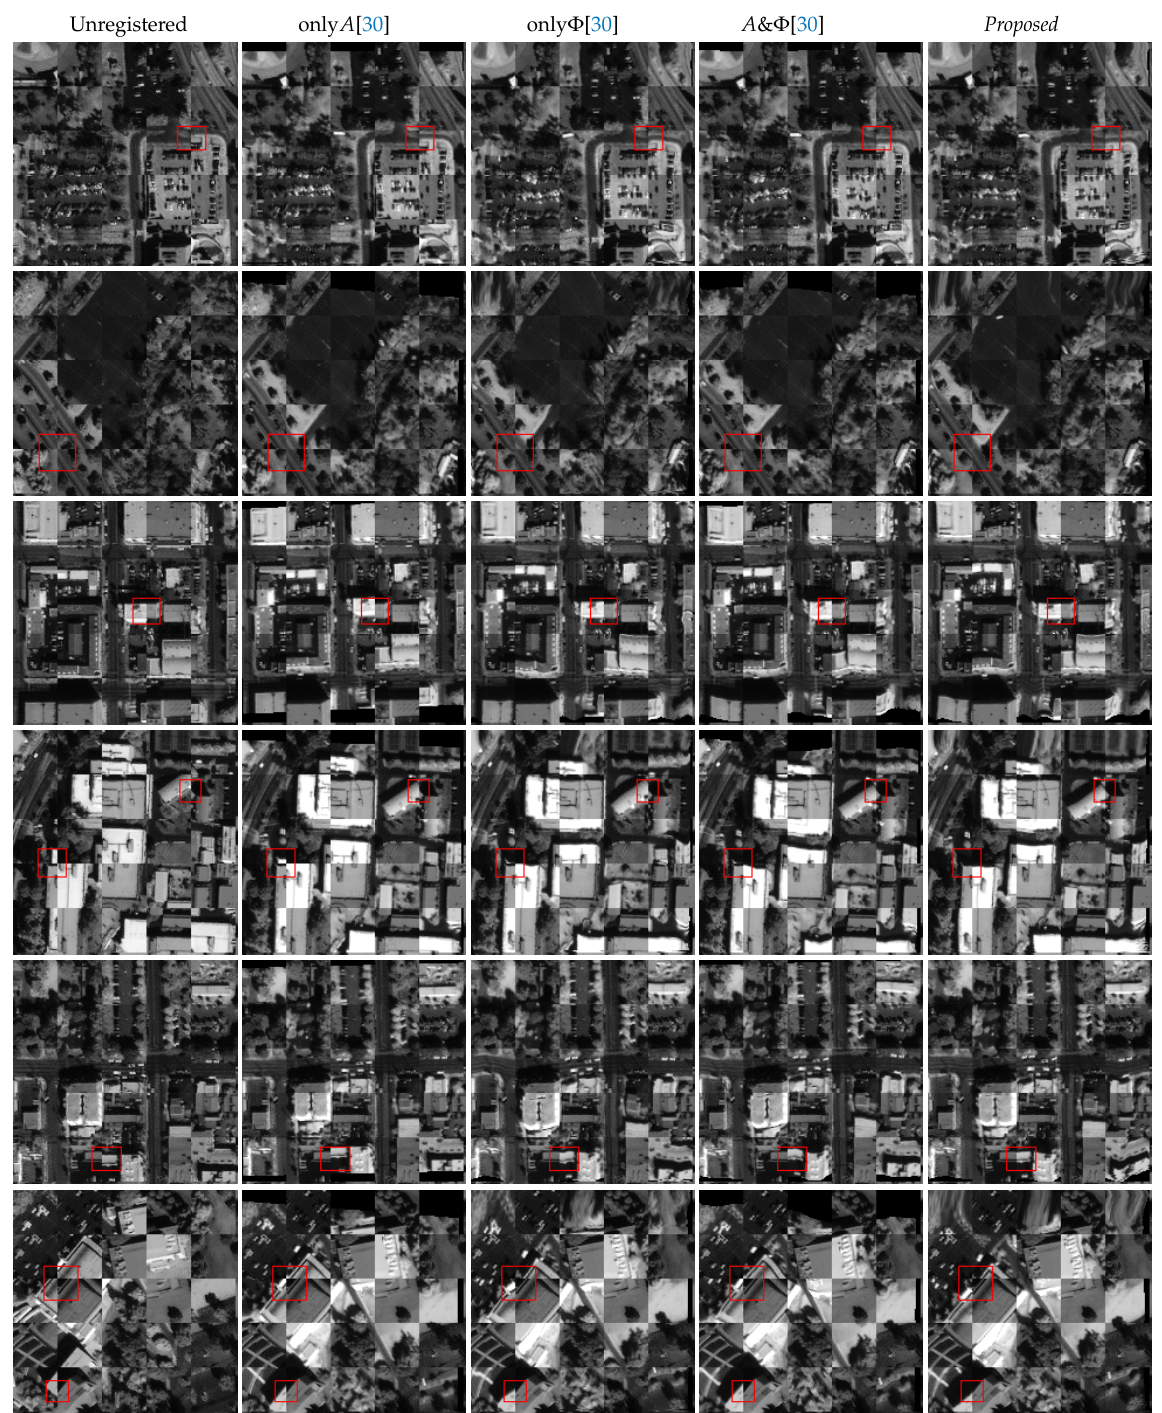
Figure 5. Qualitative evaluation on different pairs from the ISPRS Ikonos testing regions. Different approaches from [30] are compared, i.e., from left to right: Unregistered raw data, results: only A , only Φ , A & Φ , Proposed .